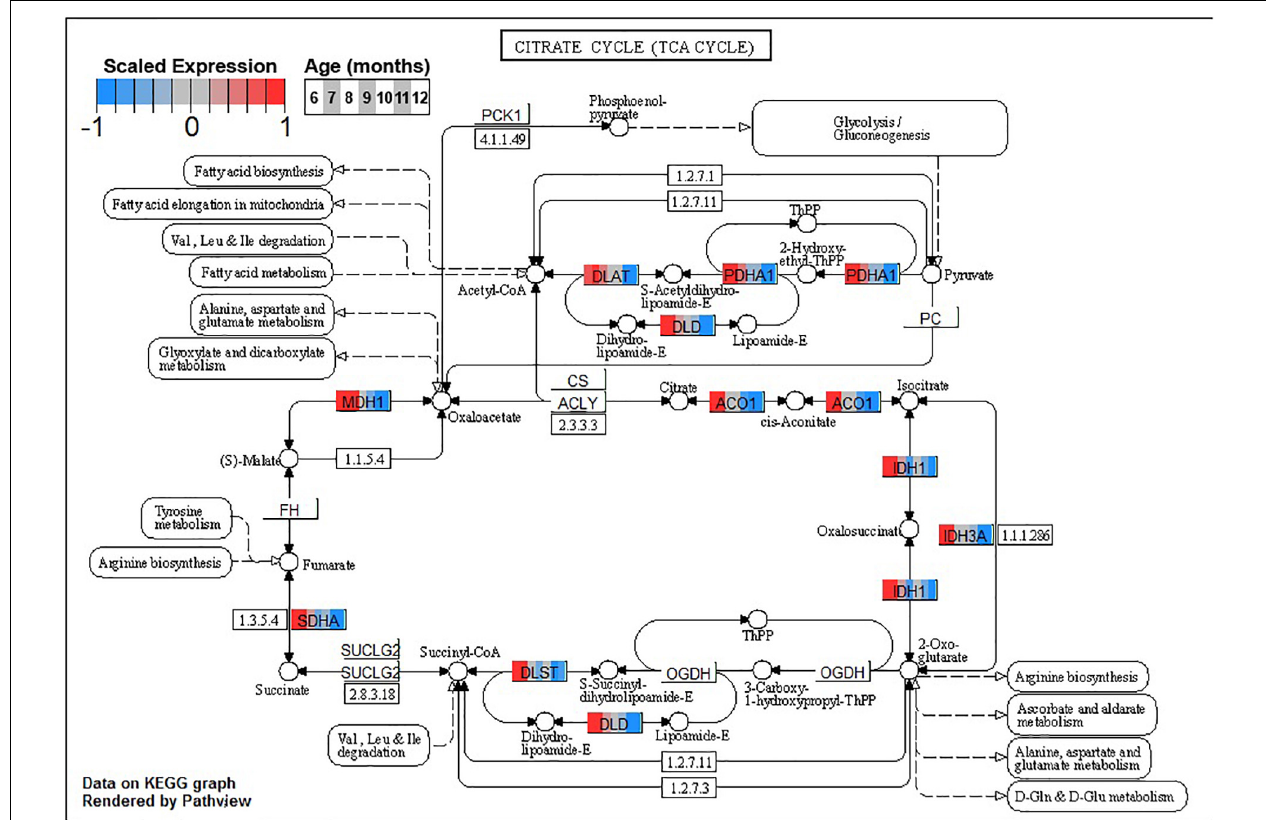
FIGURE 9 | Expression of orthologs annotated for the Kyoto Encyclopedia of Genes and Genomes (KEGG) tricarboxylic acid cycle (ko00020) pathway present in pleural ventral caudal sensory neuron (PVC) expression clusters with decreasing trend (P4 and P5). Each node of the pathway diagram represents an ortholog assigned to an Aplysia californica transcript. Nodes are divided into seven colored sections, from left to right, ages 6 to 12 months. Node sections are colored according to their mean centered and variance scaled expression, together representing the expression trends of each node across the aging process. Nodes that are not colored were absent from the gene sets of expression clusters P4 and P5. Pathway enrichment suggests decreased oxidation of acetyl-CoA in these neurons with increasing